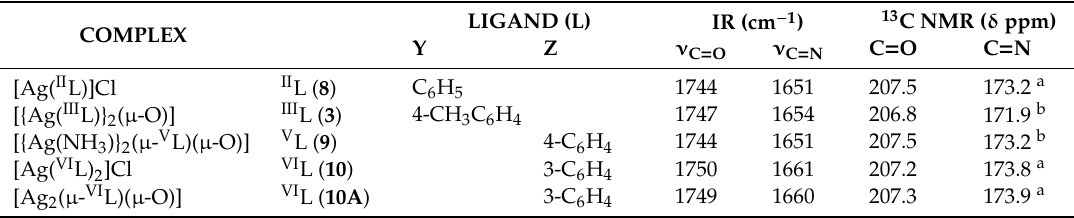
Table 2. Complexes obtained from reaction of silver chloride with camphor ligands (L). COMPLEX